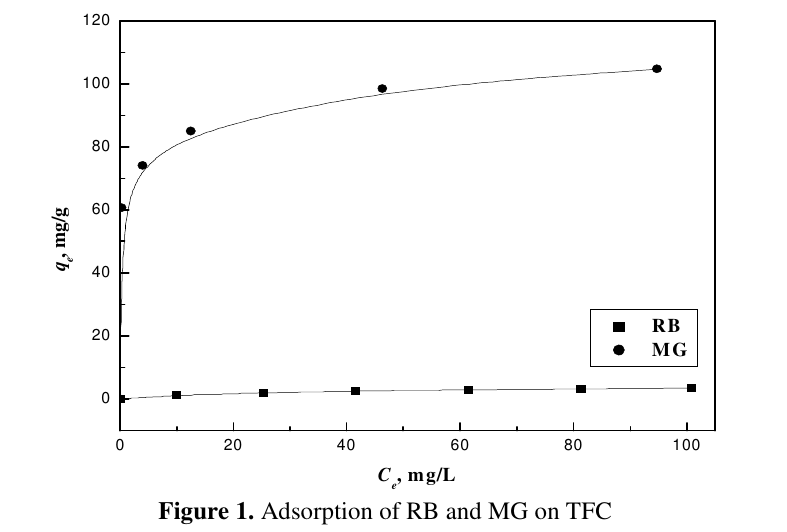
Figure 1. Adsorption of RB and MG on TFC Table 2. Isotherm constants for adsorption of dyes at 30 ° C Model parameters Dye